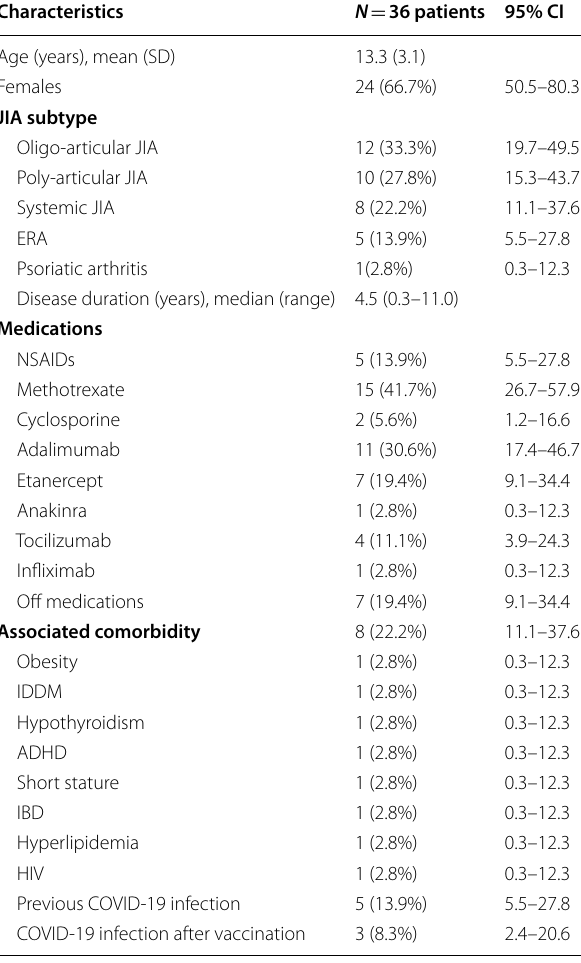
Table 1 JIA patients’ baseline